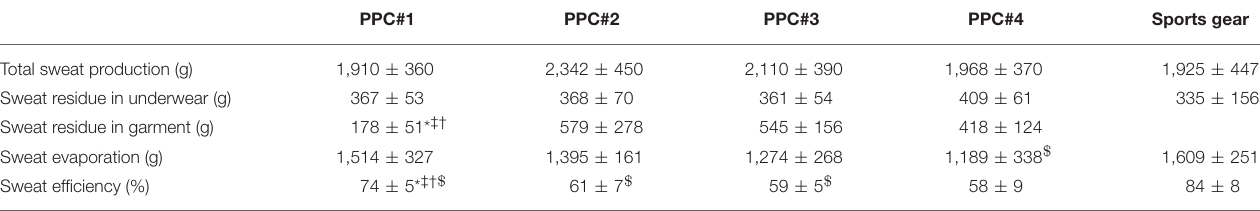
TABLE 2 | Sweat measurements analyzed in this study (mean ± SD ).